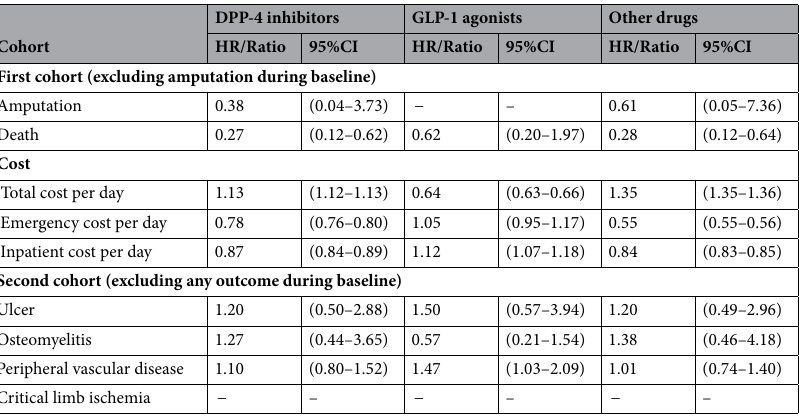
Table 3. Adjusted association between use of SGLT-2 inhibitors and outcomes of interest. Regressions with propensity score weighting adjusted for demographics (gender and age), diabetes severity, comorbidities (cerebrovascular disease, congestive heart failure, ischemic heart disease, hypertension, retinopathy, nephropathy, neuropathy, atrial fibrillation, renal disease, and eye disease) and medication histories during the baseline period (angiotensin-converting enzyme inhibitors, anticoagulants, angiotensin receptor blockers, aspirin, antiasthmatic drugs, bile acid sequestrants, carbonic anhydrase inhibitors, calcium channel blockers, fibrates, hormone replacement therapy, loop diuretic, β-blockers, platelet aggregation inhibitors, potassium- sparing diuretic, statins, and thiazides). CI, confidence interval; DPP-4, dipeptidyl peptidase 4; GLP-1, glucagon-like peptide 1; HR, hazard